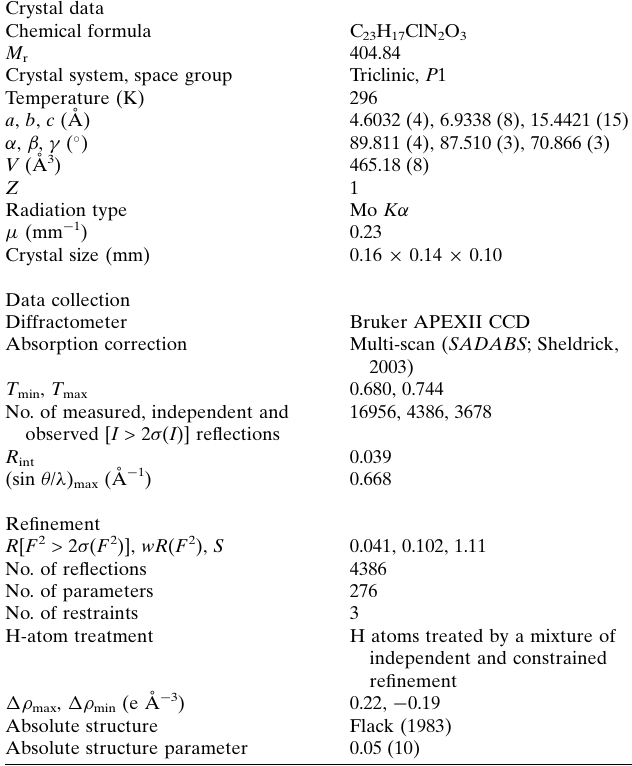
Figure 2 A view along the c axis of the crystal packing of the title compound. H bonds are shown as dashed lines and H atoms not involved in these interactions have been omitted for clarity.